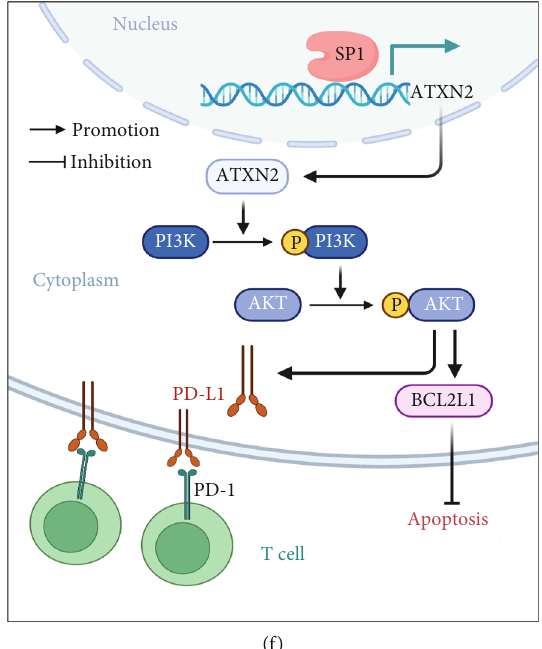
Figure 6: SP1 a ff ected chemoresistance and immunotherapy. (a) Correlation analysis of SP1, BCL2L1, and PD-L1 in the GEPIA and TCIA databases. (b, c) The expression of BLC2L1 and PD-L1 in SGC7901 cells (b) and SGC7901/5-FU cells (c). (d) The apoptosis rate of SGC7901 cells with SP1 overexpression, ATXN2 silencing, and BCL2L1 silencing. (e) SGC7901 cells overexpressing SP1 were treated with an AKT inhibitor or nivolumab and cocultured with CD8 + T cells. The survival rate of SGC7901 cells was measured. (f) Schematic of the model for the SP1/ATXN2/PI3K-Akt/BCL2L1 and SP1/ATXN2/PI3K-Akt/PD-L1 pathways. The schematic was created with http://biorender .com. ∗∗ P < 0 : 01